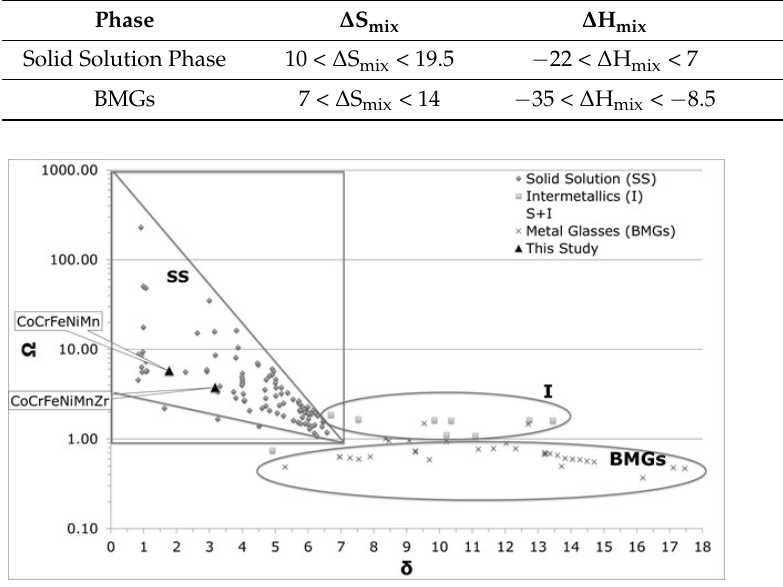
Table 5. Suitable range to form solid solution.